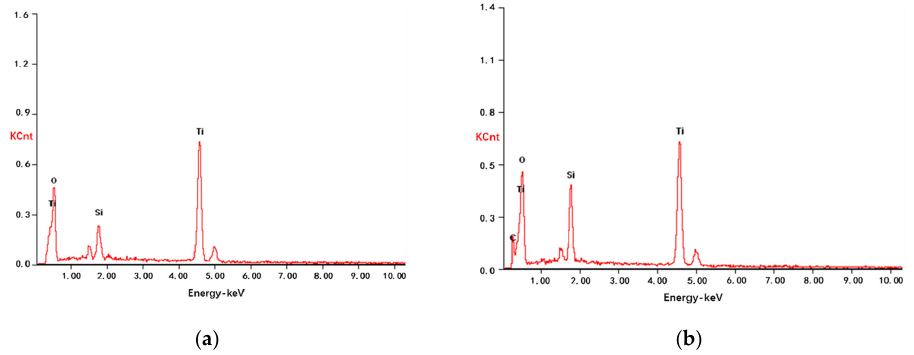
Figure 2. The energy-dispersive spectrometer (EDS). ( a ) TiO 2 (unmodify), ( b ) TiO 2 (modify).